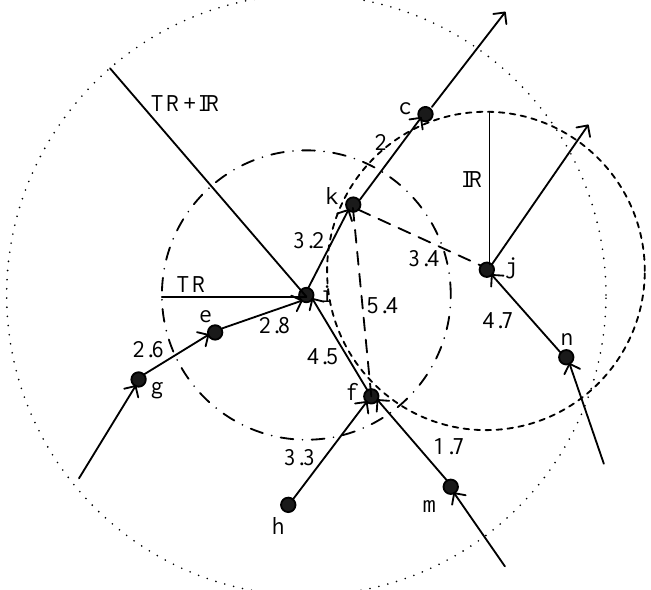
Figure 2. Local network topology of node i